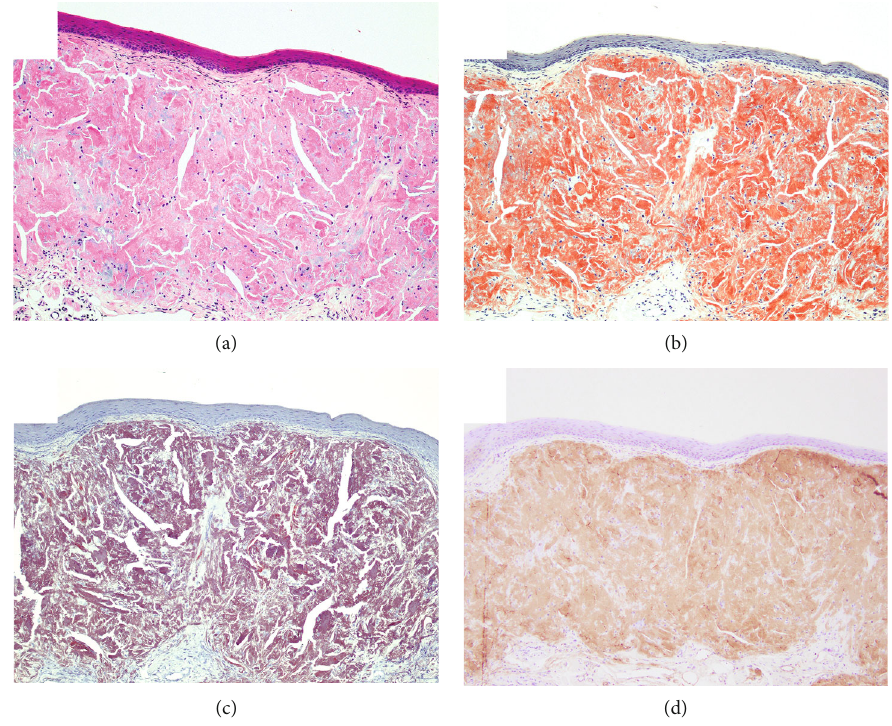
Figure 3: (a) Amorphous extracellular eosinophilic deposits are shown in the subepithelial region (hematoxylin-eosin stain, original magni fi cation × 100). (b) Extracellular deposits show positive staining with direct fast scarlet (DFS) (original magni fi cation × 100). (c) Extracellular deposits show positive staining with potassium permanganate- (KMnO Staining for β 2-microglobulin is also positive (original magni fi cation ×